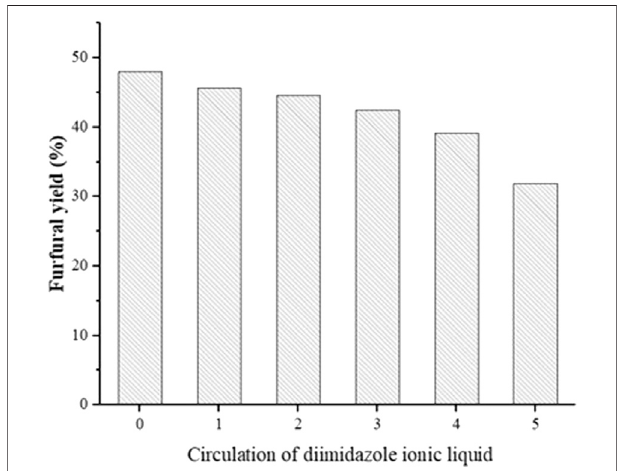
FIGURE 6 | The reusability of the catalyst. Reaction conditions: xylose (60 g/L), 0.6 g C 1 MF, 205 ° C, 10 min.